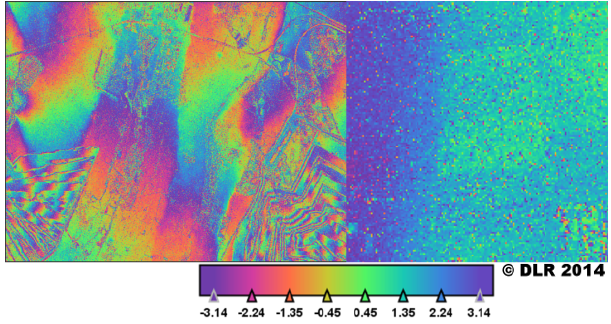
Figure 2. Interferogram generated from the TDM pair of July 15, 2014 (HH-Polarisation), left: whole scene, right: over the intensively monitored maize